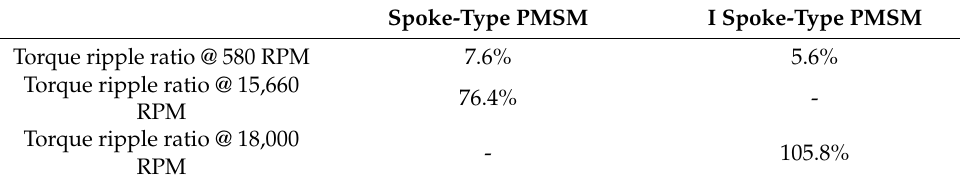
Table 3. Torque ripple comparison of two motors.